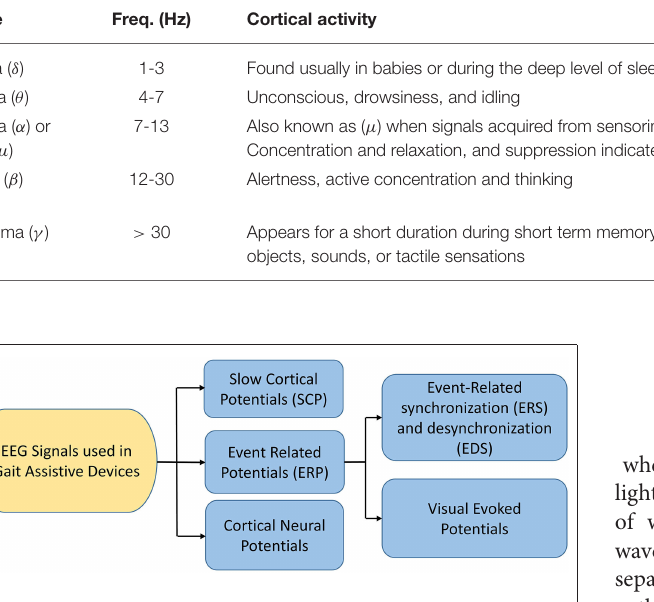
FIGURE 3 | EEG signals used in BCI (Ramadan and Vasilakos, 2017; Tariq et al., 2018).